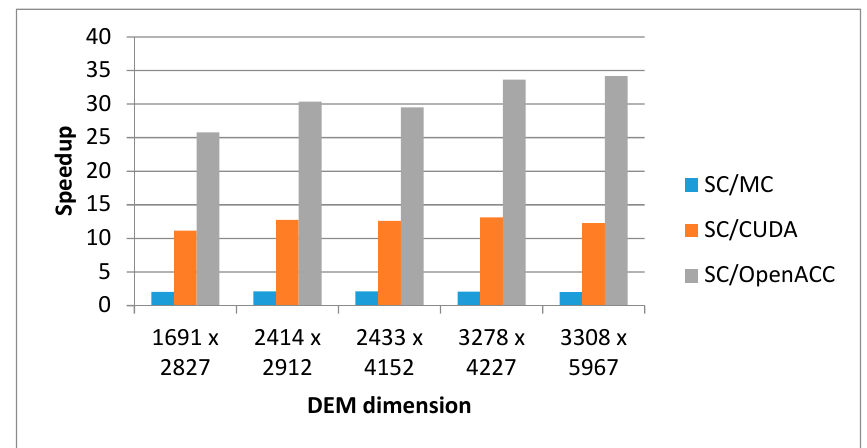
Figure 8. Speedup for the MFD algorithm.